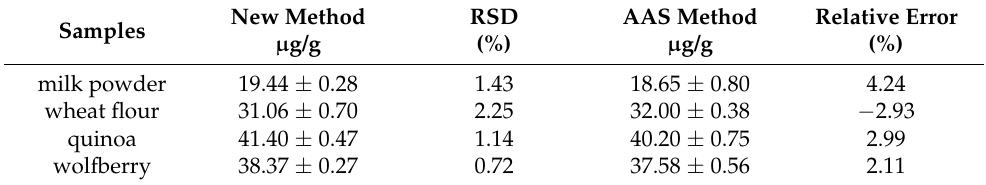
Table 4. Comparison of new method and AAS method for Ag + determination in food samples ( n = 3).